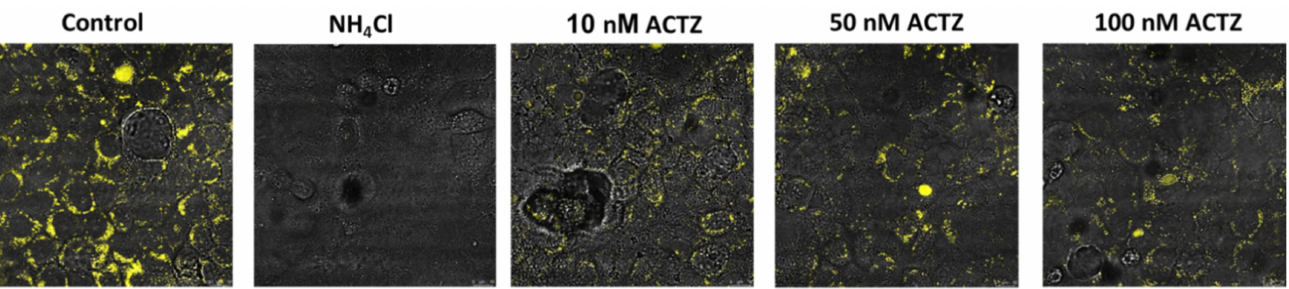
Figure 3. Acetazolamide interferes with lysosomal acidification. Acetazolamide (ACTZ) is a pan- carbonic anhydrase (CA) inhibitor. These enzymes are important in the catalysis of the dissociation of H 2 CO 3 to HCO 3 − and H + . Based on the activity of CA in endo/lysosomal compartments, we examined the effect of ACTZ on lysosomal pH using LysoSensor blue reagent. Treatment of Vero 6 cells with ACTZ at 50 nm significantly prevented the acidification of lysosomes. Both lower (10 nm) and well higher concentrations of ACTZ (100 nm) were able to significantly inhibit the acidification of lysosomes (Figure 3). ( Unpublished data from the author’s laboratory